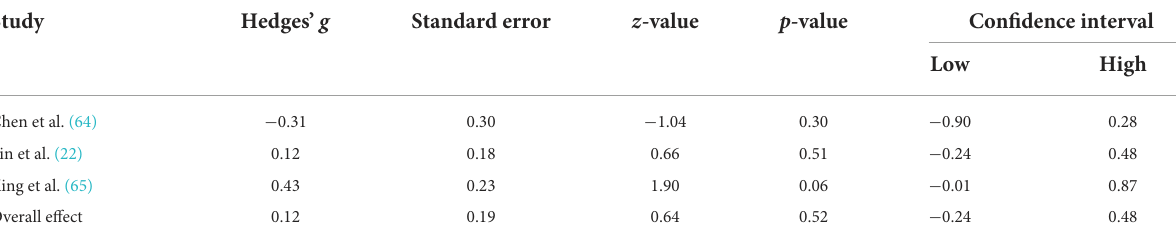
TABLE 7 Mean analysis results for whole-brain